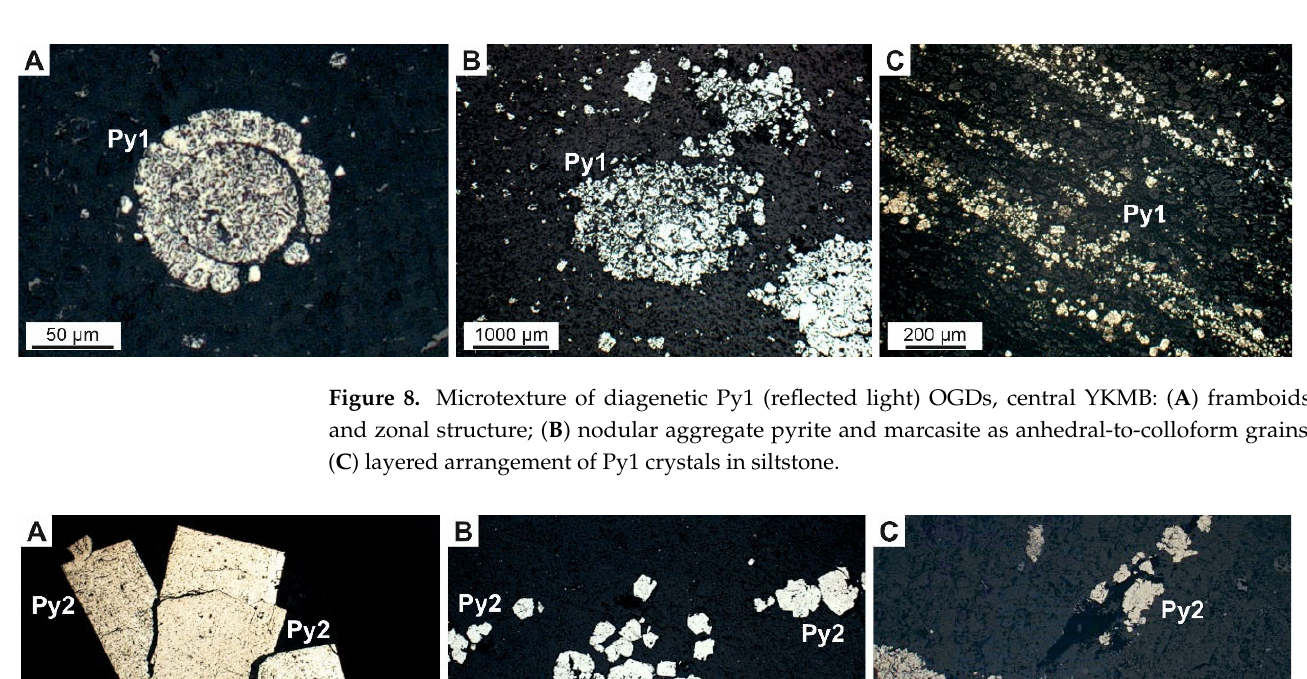
Figure 9. Microtextures of metamorphic pyrite2 (reflected light) OGDs, central YKMB: ( A ) inter ‐ growths of cubic pyrite; ( B ) accumulation of crystals and pyrite intergrowths. The central part of the individual grains is corroded; ( C ) micro ‐ veinlets of pyrite along cracks.